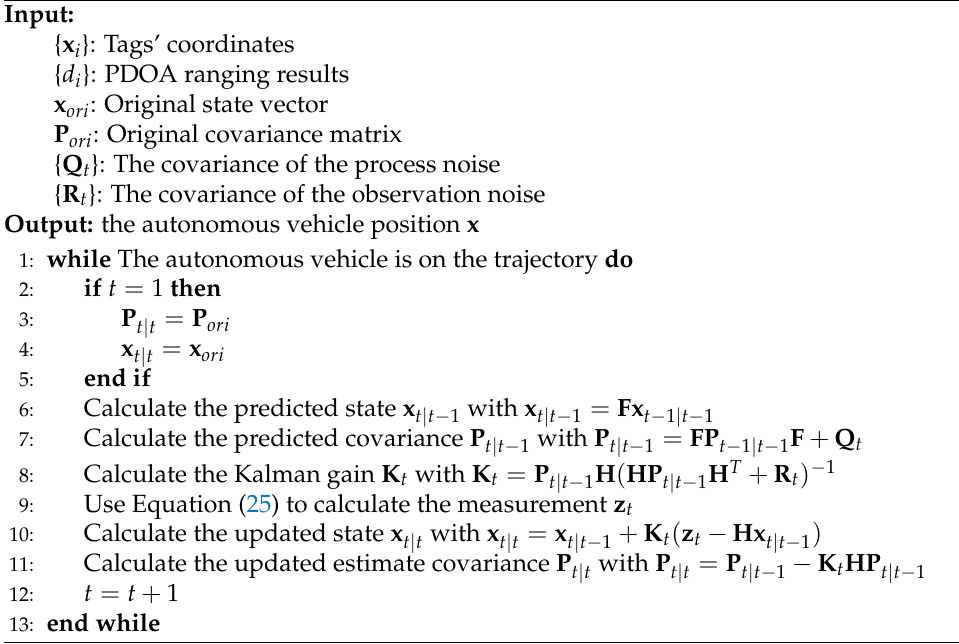
Algorithm 1 UHF RFID-based indoor autonomous vehicle localization and tracking